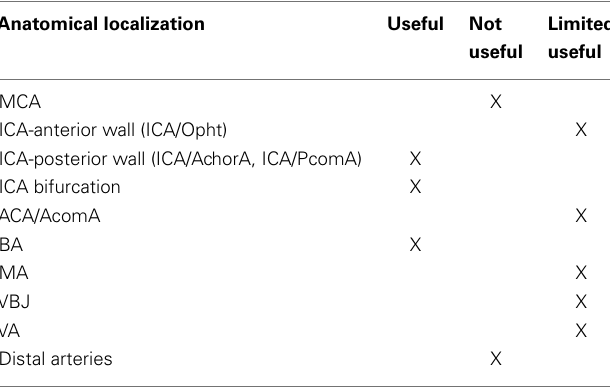
Table 2 |Anatomical localizations that gain advantages or not from the endoscopic procedures